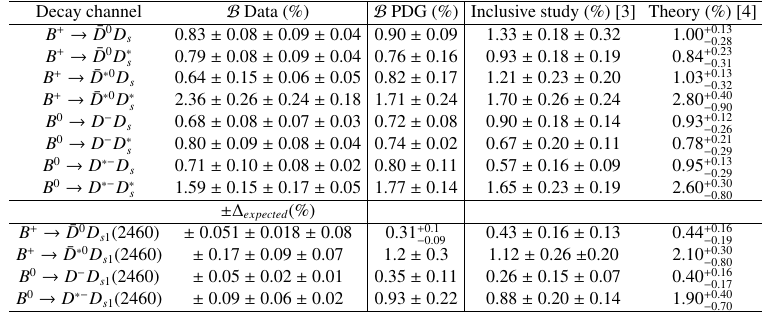
Figure 5. GMC fit results to the full range missing mass distribution for B 0 → ¯ D − D ( ∗ ) B 0 → ¯ D ∗− D ( ∗ ) (right). The description of the resonances is given on the previous figure (fig. 4). s ( J )